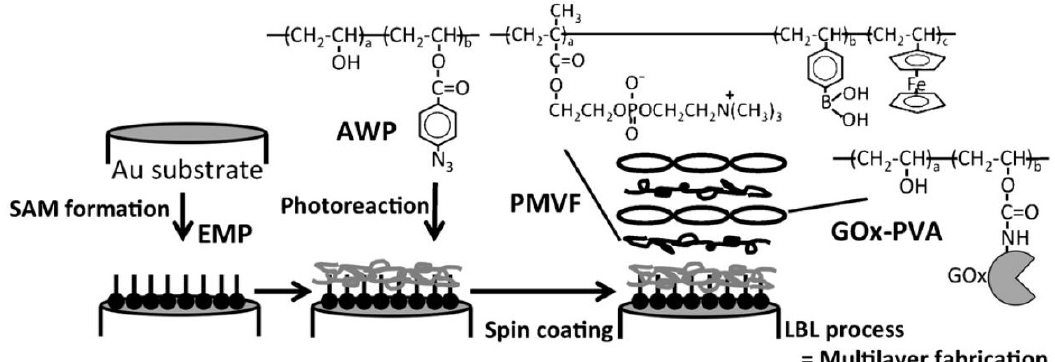
Figure 4. A glucose sensor prepared using phosphorylcholine polymers containing an